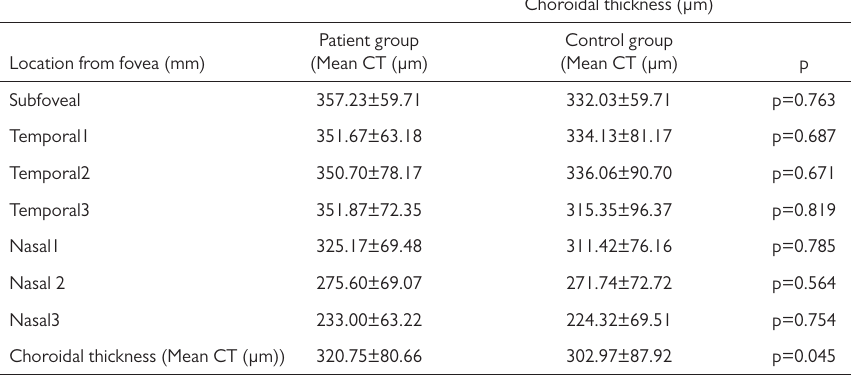
Table 1. Choroidal thickness values for the patient and control groups